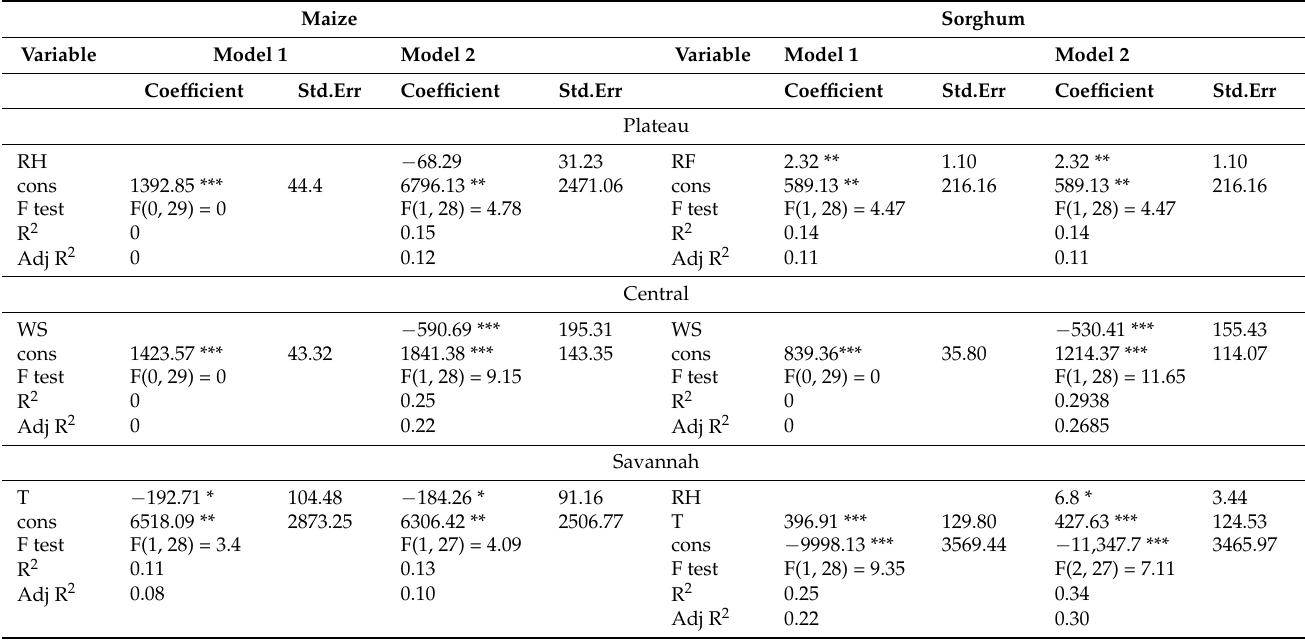
Table 4. Stepwise regression results on the impact of weather variables on maize and sorghum yield over the entire growth.